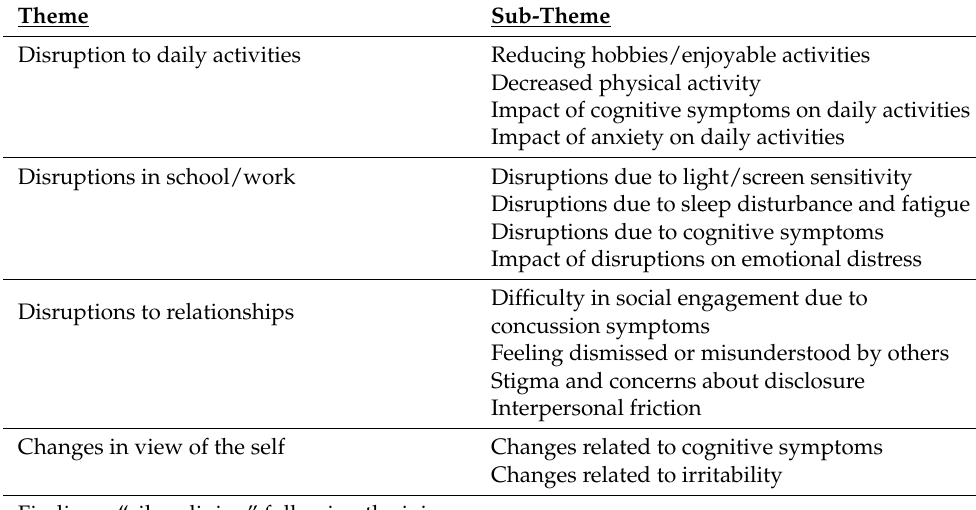
Table 2. Themes and